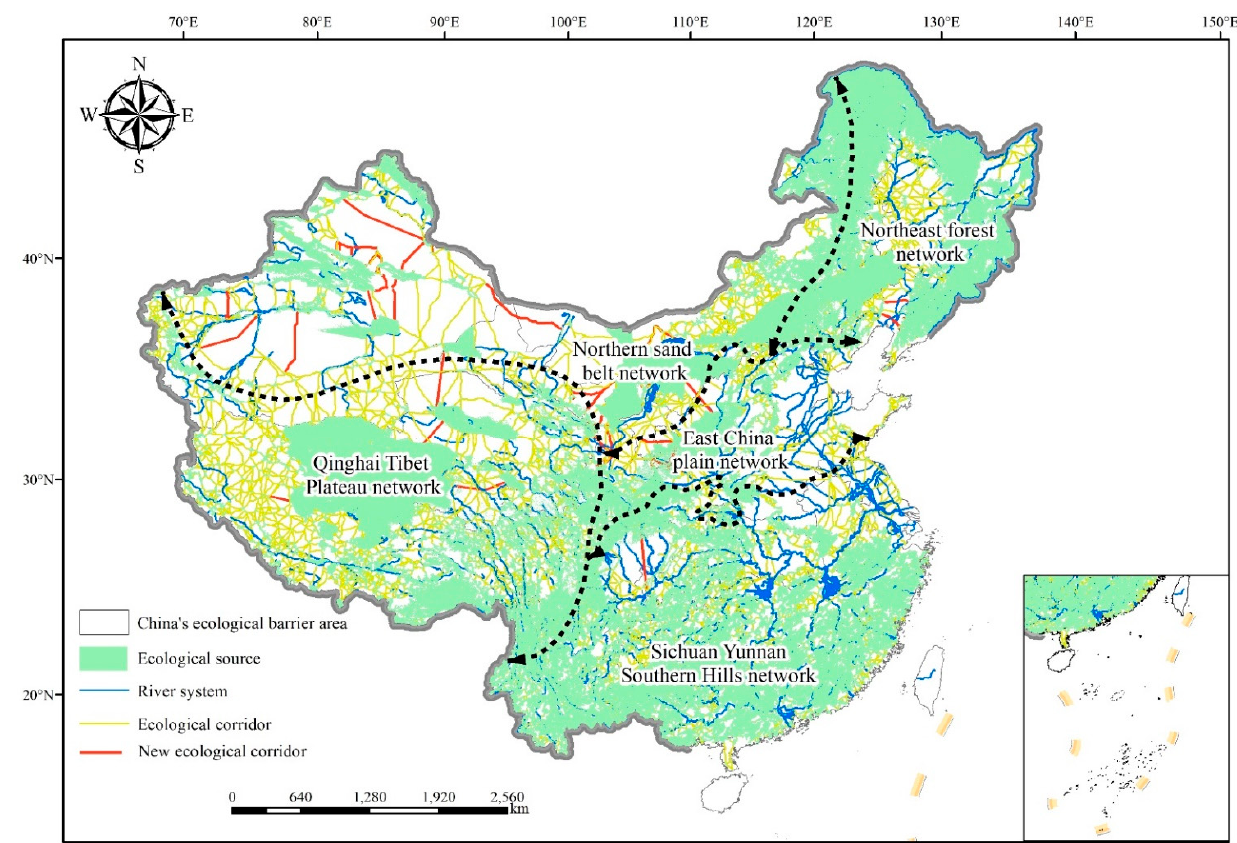
Figure 10. Geographical divisions of China’s eco − spatial network.